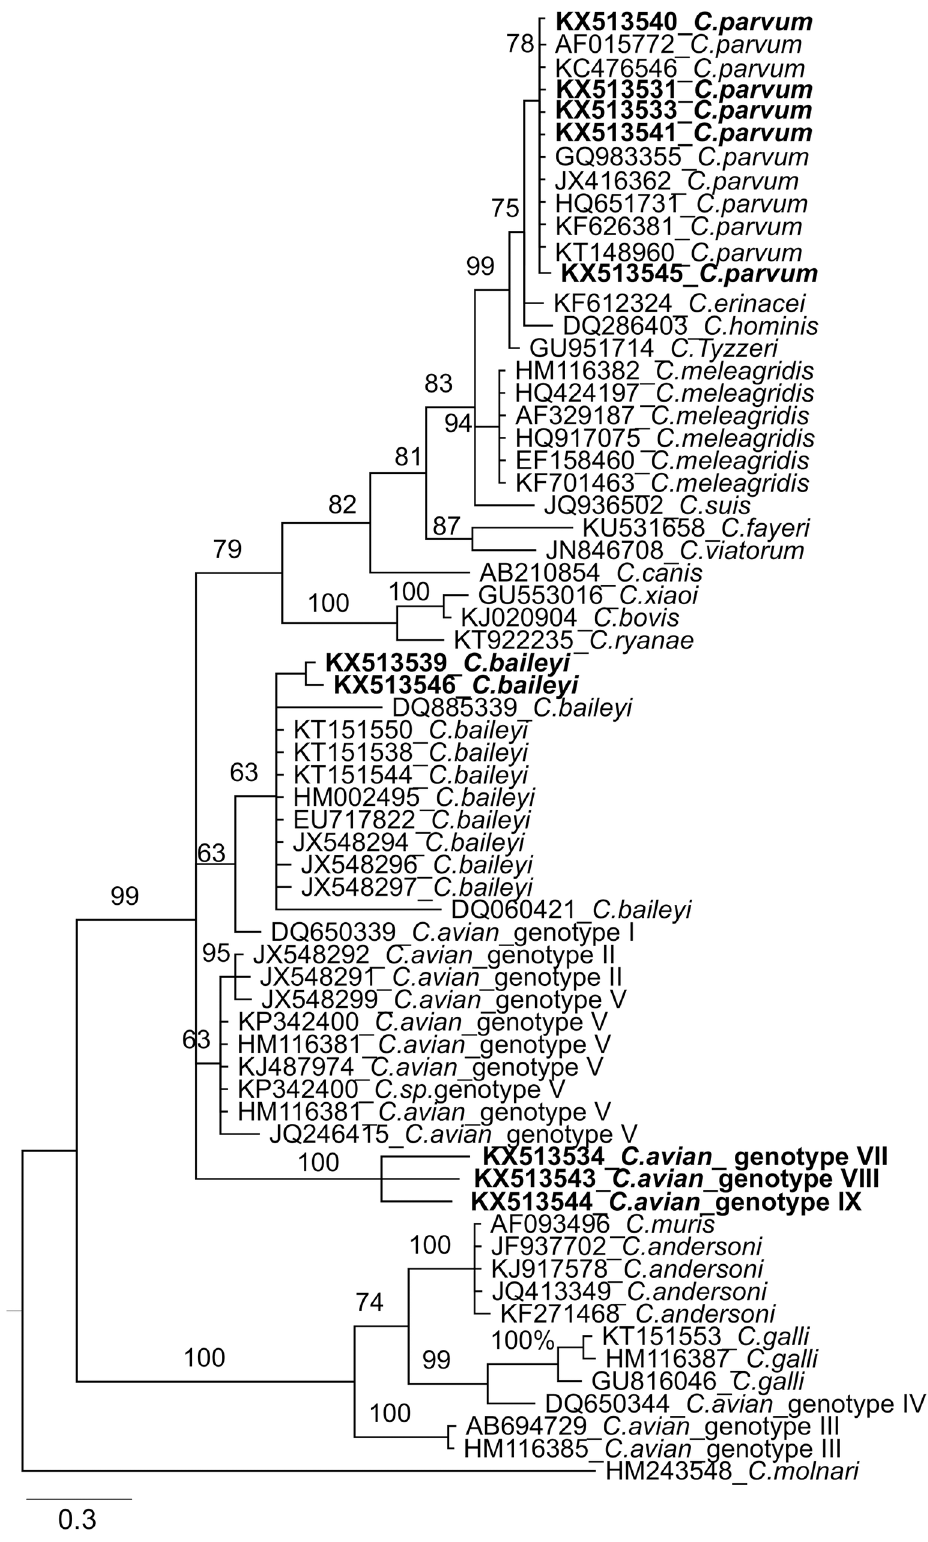
Fig 1. Phylogenetic relationship of the 18S rDNA of Cryptosporidium strains detected in chickens and turkeysin Germany. A mid-pointrooted tree was generatedbasedon the best fit substitution